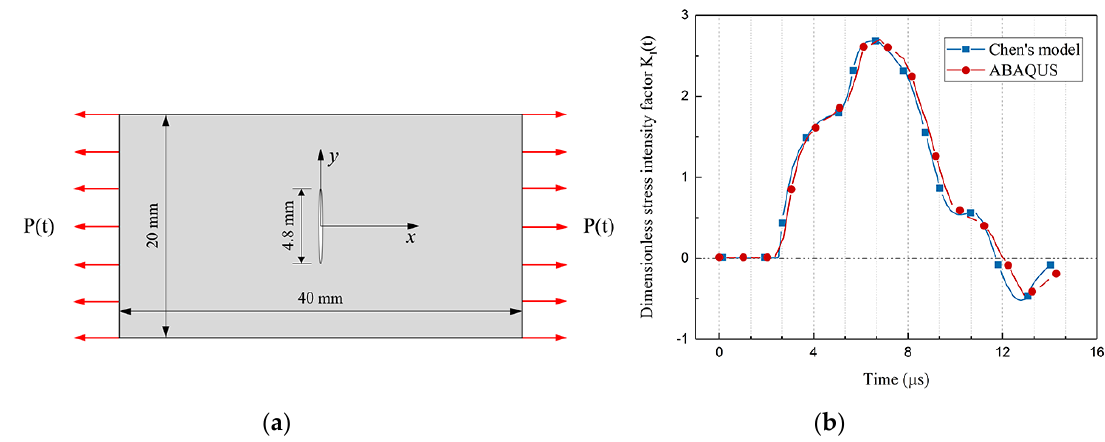
Figure 8. Verification of the ABAQUS. ( a ) The geometry of Chen’s model. ( b ) Comparison between Chen’s model and ABAQUS.